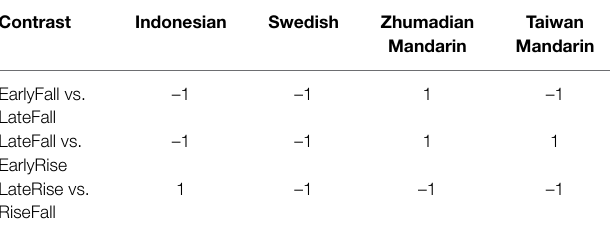
TABLE 2 | Experimental pitch contrasts functioning as phonological contrasts.